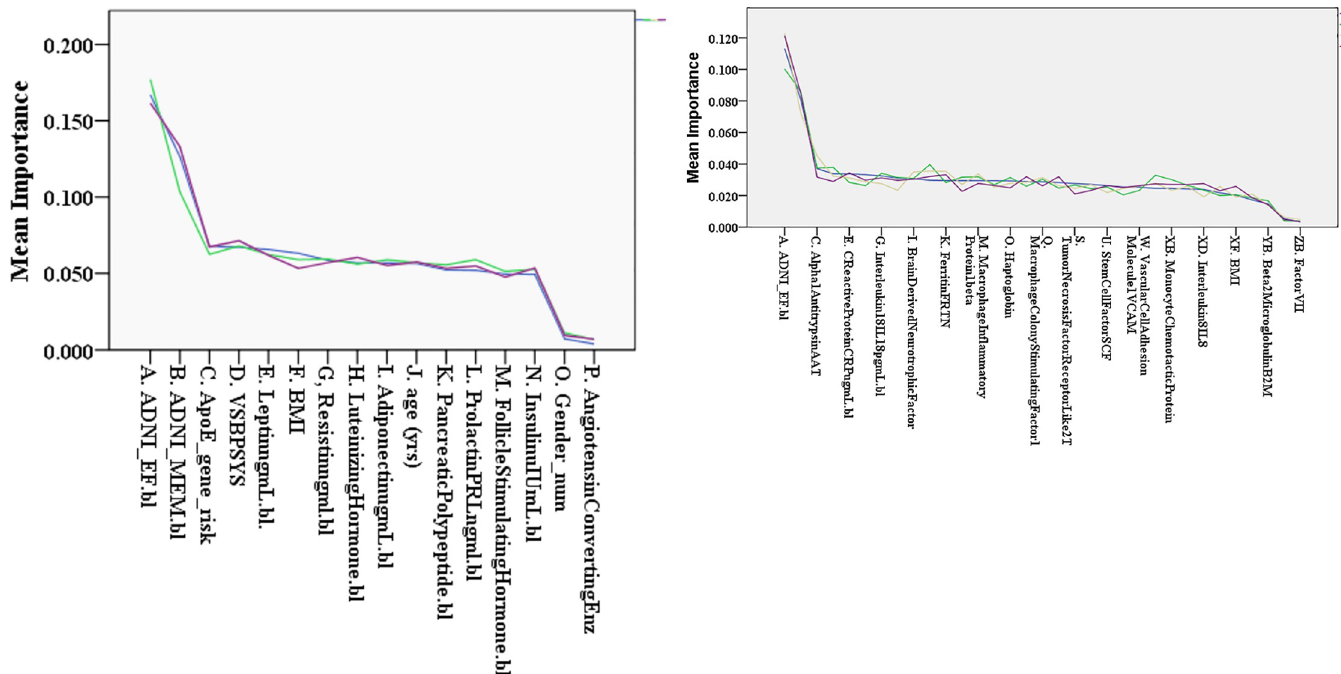
Fig 8. a & b represent plots of the importance coefficients (y axis) ordered on the X axis by feature importance. We used the mean importance from 3–4 subject groups, but the same features for each. Each line represents a different subject group. Top panel [a] is for the groups described above including Kit Metabolic and Panel [b] is for same plus Kit Inflammatory. The average ordering is shown. The general profile of the GINI coefficients is illustrated by the